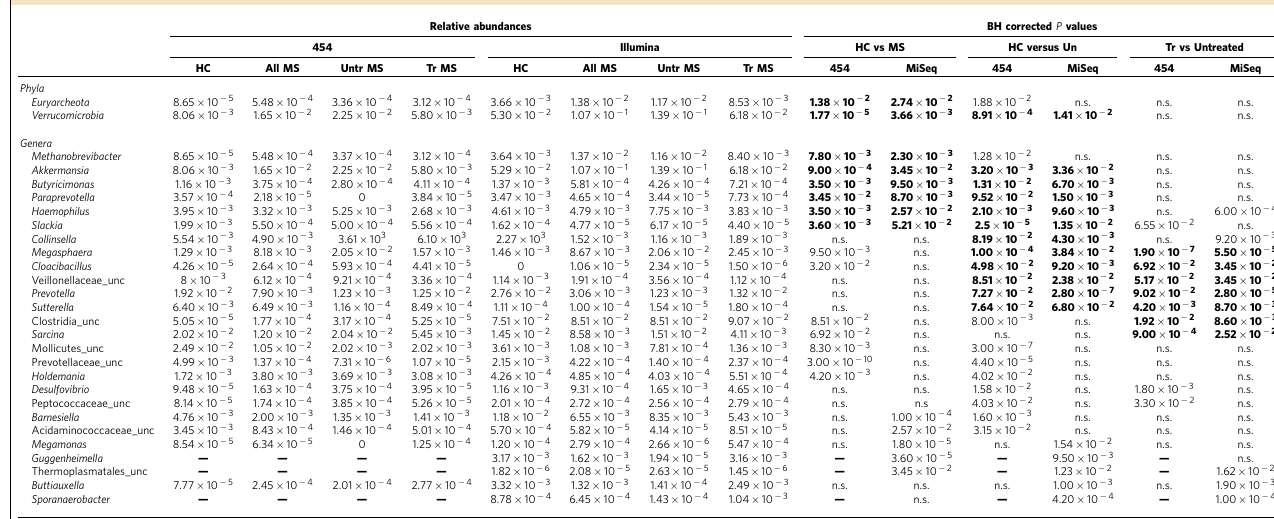
Table 2 | Multiple sclerosis and MS-treatment-associated taxa.